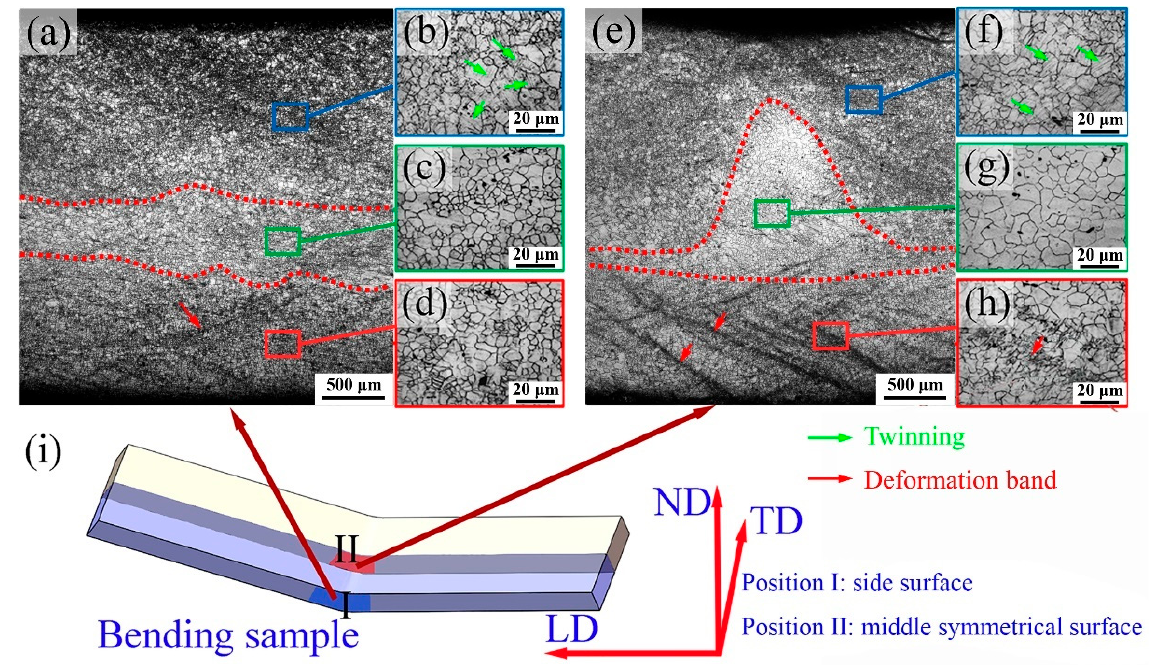
Figure 3. Optical micrographs ( a – d ) of the side surface (position I in Figure 3i) and ( e – h ) middle symmetrical surface (position II in Figure 3i) perpendicular to the transverse direction (TD) of the sample when the bending test interrupts at the punch stroke of 1.5 mm and ( i ) schematic diagram of the bending sample.